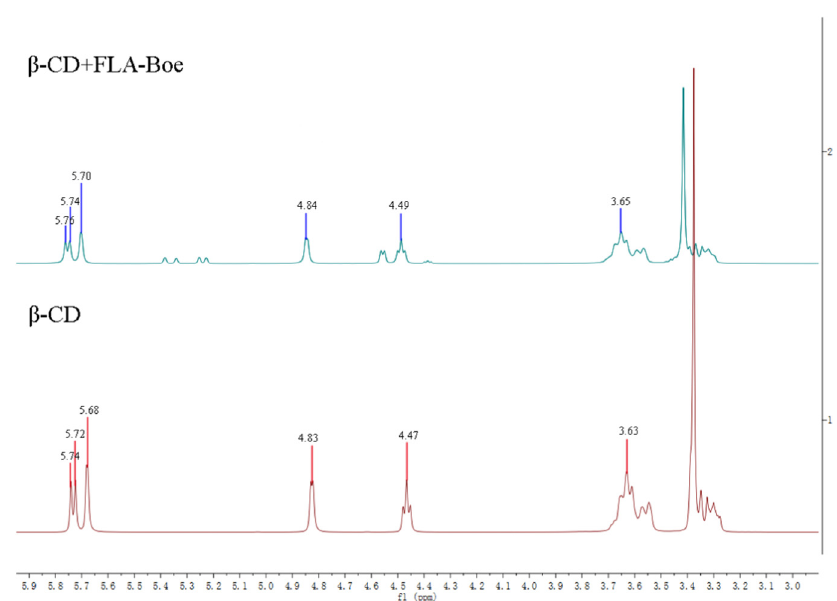
Figure 7. 1 H NMR spectra of pure β -CD and β -CD- FLA-Boe . Table 1. 1 H NMR chemical shifts ( δ , ppm) of pure β -CD and β -CD- FLA-Boe .